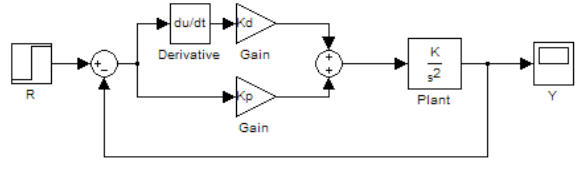
Figure 19: P‐D control strategy block diagram Figure 20. PD control strategy block diagram ( k p = 0 . 52 and k d = 0 . 23 ; cf. equations 2 and 3).